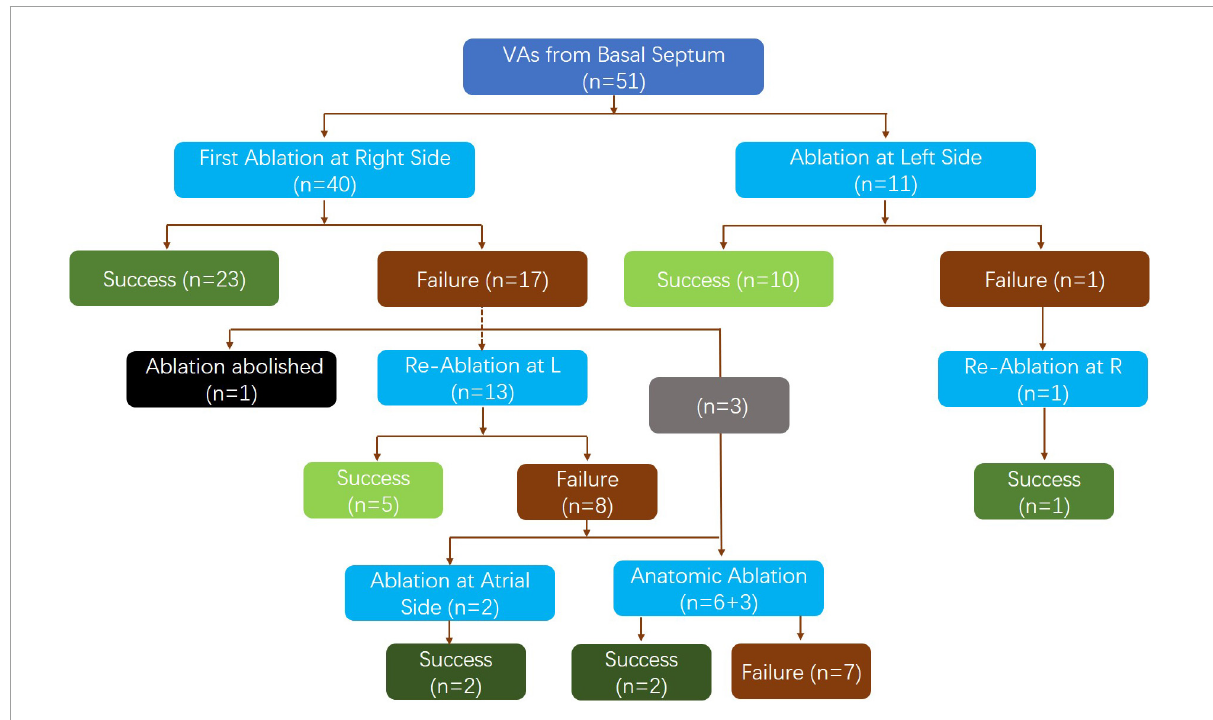
FIGURE1 Flow chart of the detailed basal septum VA ablation results in acute term.